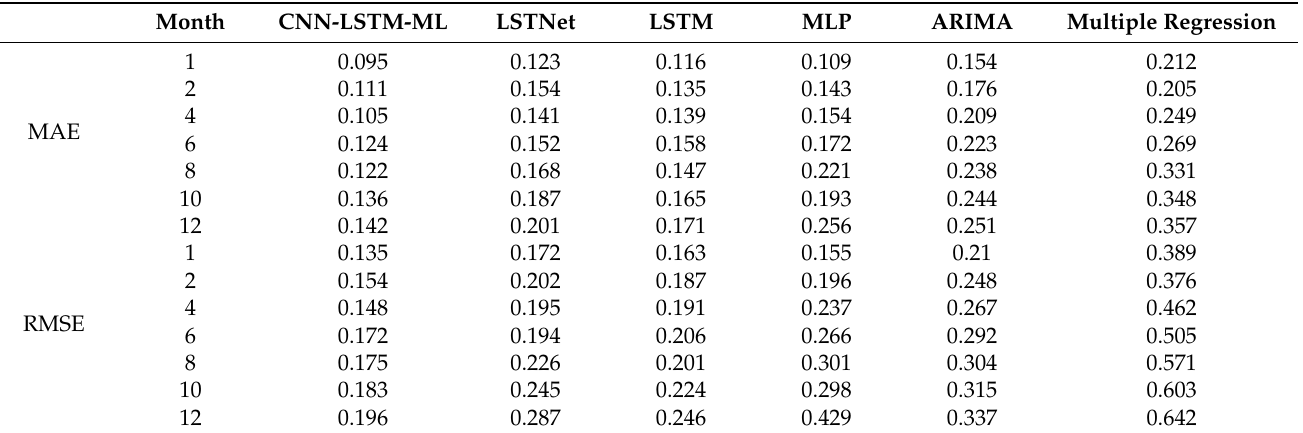
Table 1. Predictive accuracy of groundwater